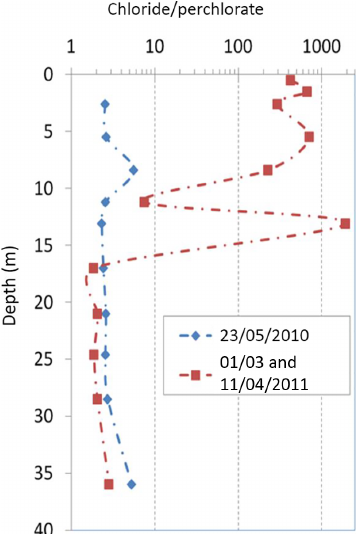
Figure 8. Chloride-to-perchlorate equivalent concentration ratio profiles before and after the infiltration experiments. Dates are given as day/month/year. Note that data points are aligned in a slanted ori- entation and interpolated as time